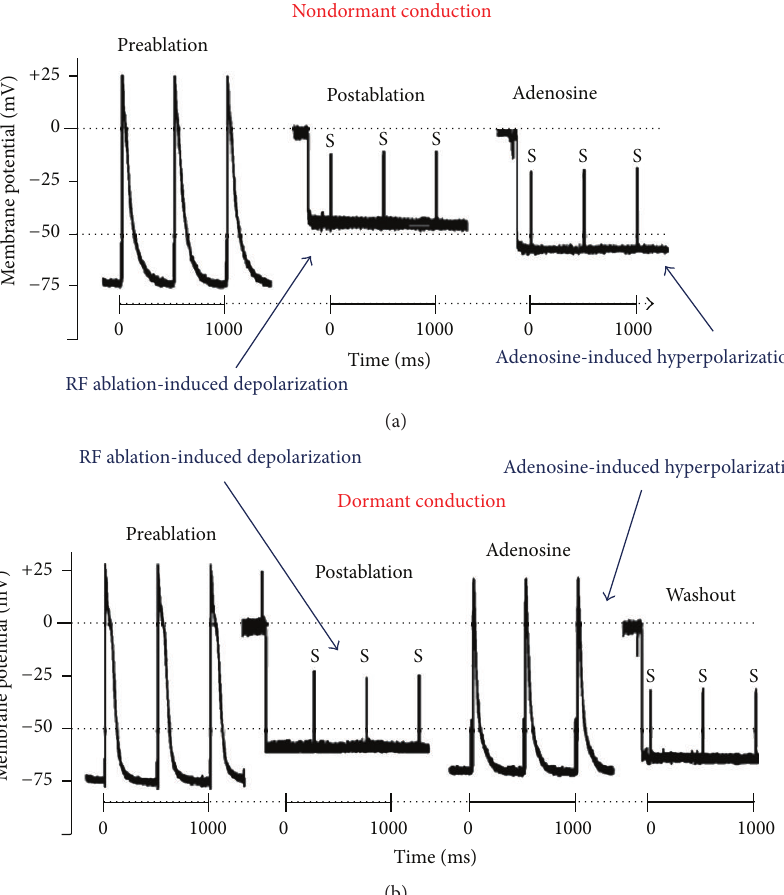
Figure 1: Microelectrode recordings before and after pulmonary vein isolation in a PV without dormant conduction (upper panel) and in a PV with dormant conduction (lower panel). S: stimulus artifacts with no response. Dotted line: excitability threshold at − 50 mV (adapted from Datino et al.